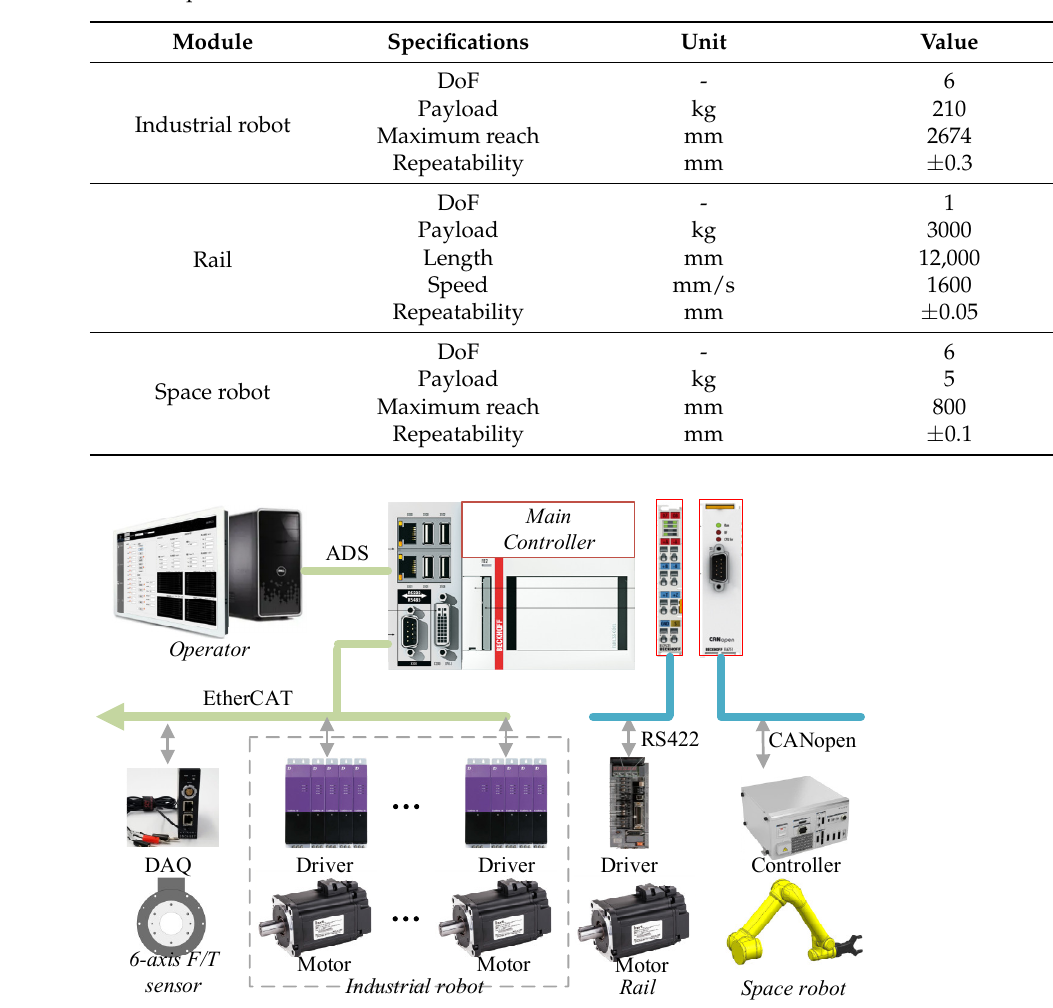
Figure 2. Control system of the HIL simulator.